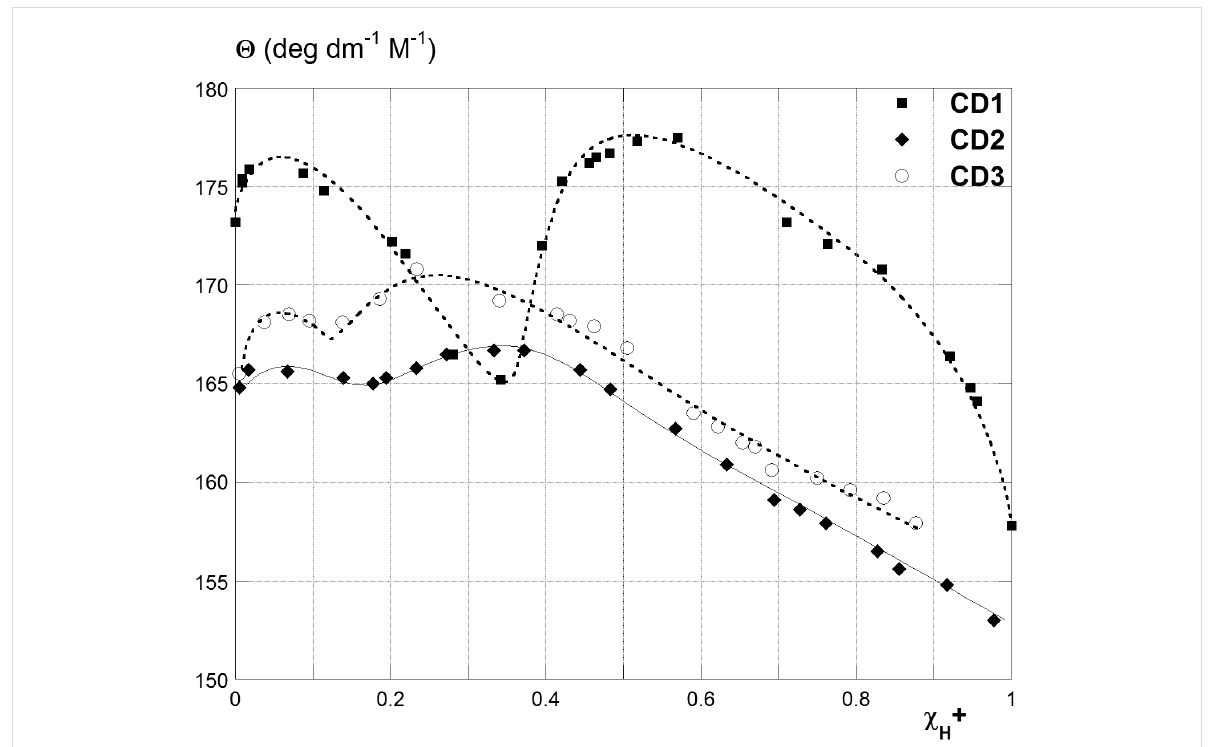
Figure 3: Trends of the molar optical rotation Θ of AmCDs vs χ H+ .